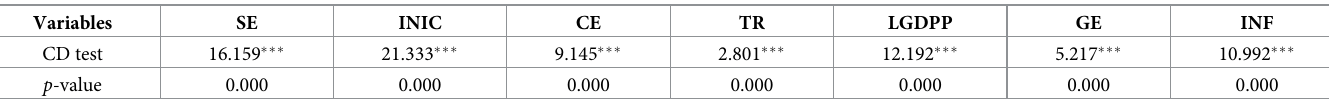
Table 4. Cross-section dependence test results.